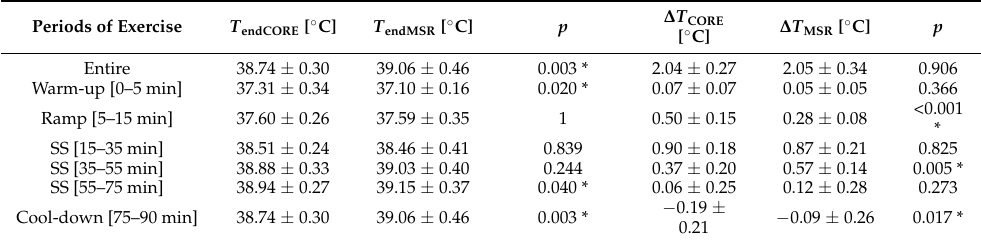
Table 6. Mean temperatures during the final 30 sec of the entire exercise protocol in Study II, as well as of each individual phase of this exercise, as measured with the CORE ( T endCORE ) and MSR rectal ( T endMSR ) sensors. In addition, the fourth and fifth columns indicate the total increase in temperature during each